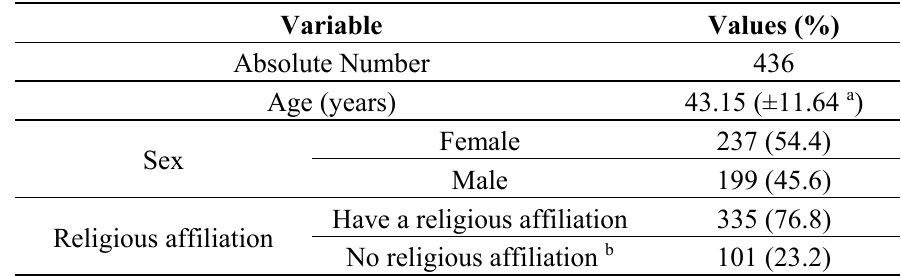
Table 1. Characteristics of survey